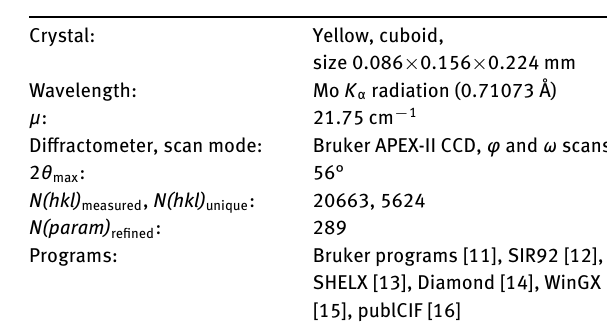
Table 1: Data collection and handling.